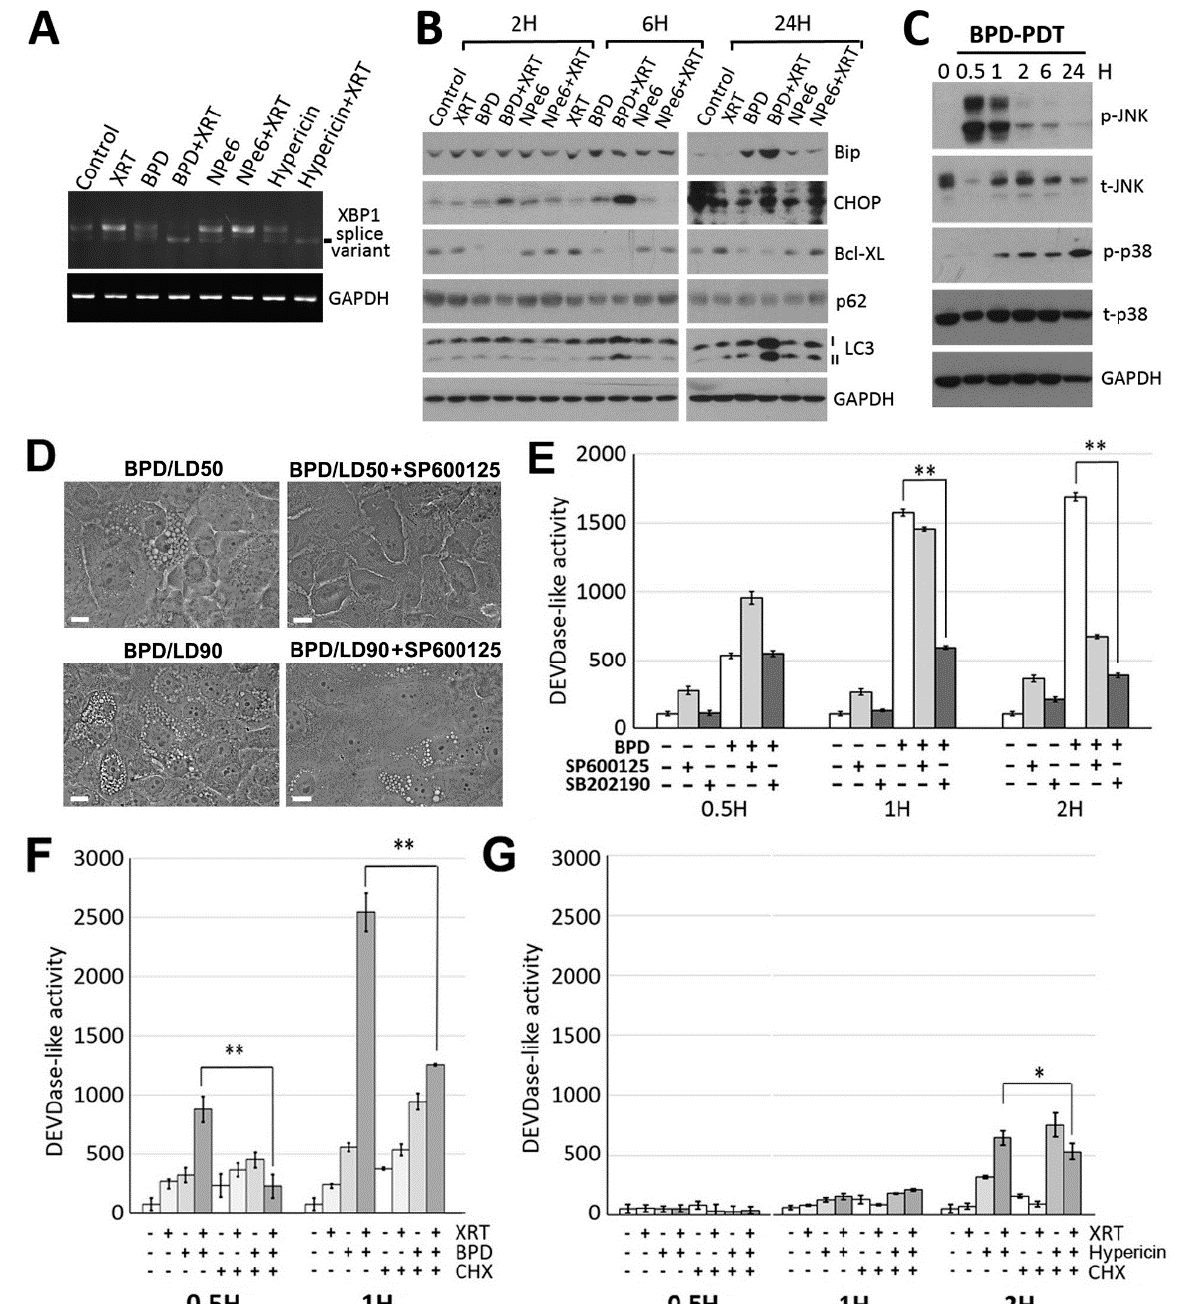
Figure 3. ER-targeted PDT induced ER stress signaling, and BPD-PDT sensitized WSU12 cells to XRT via